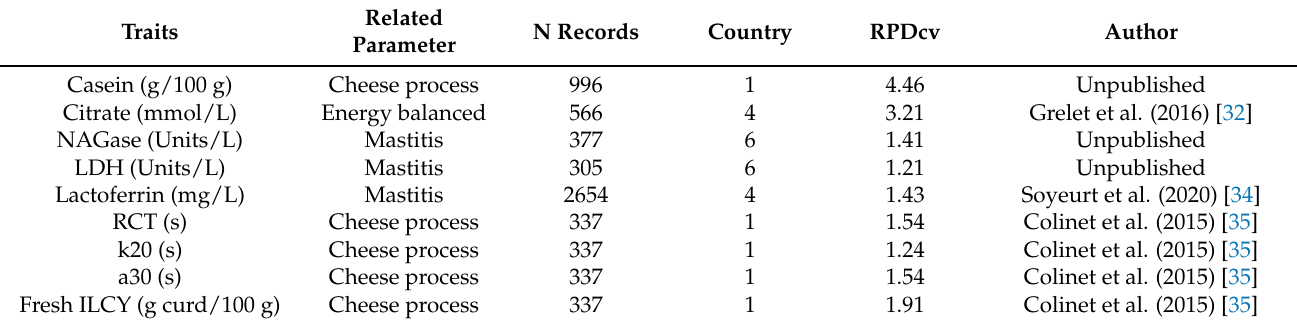
Table 1. Equations predicting traits related to animal health and milk technological